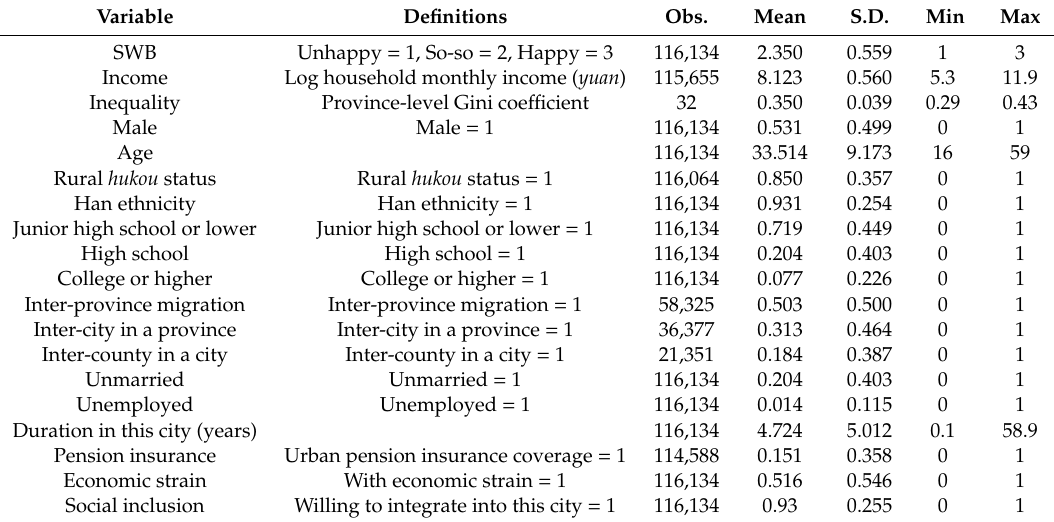
Table 1. Variable Definitions and